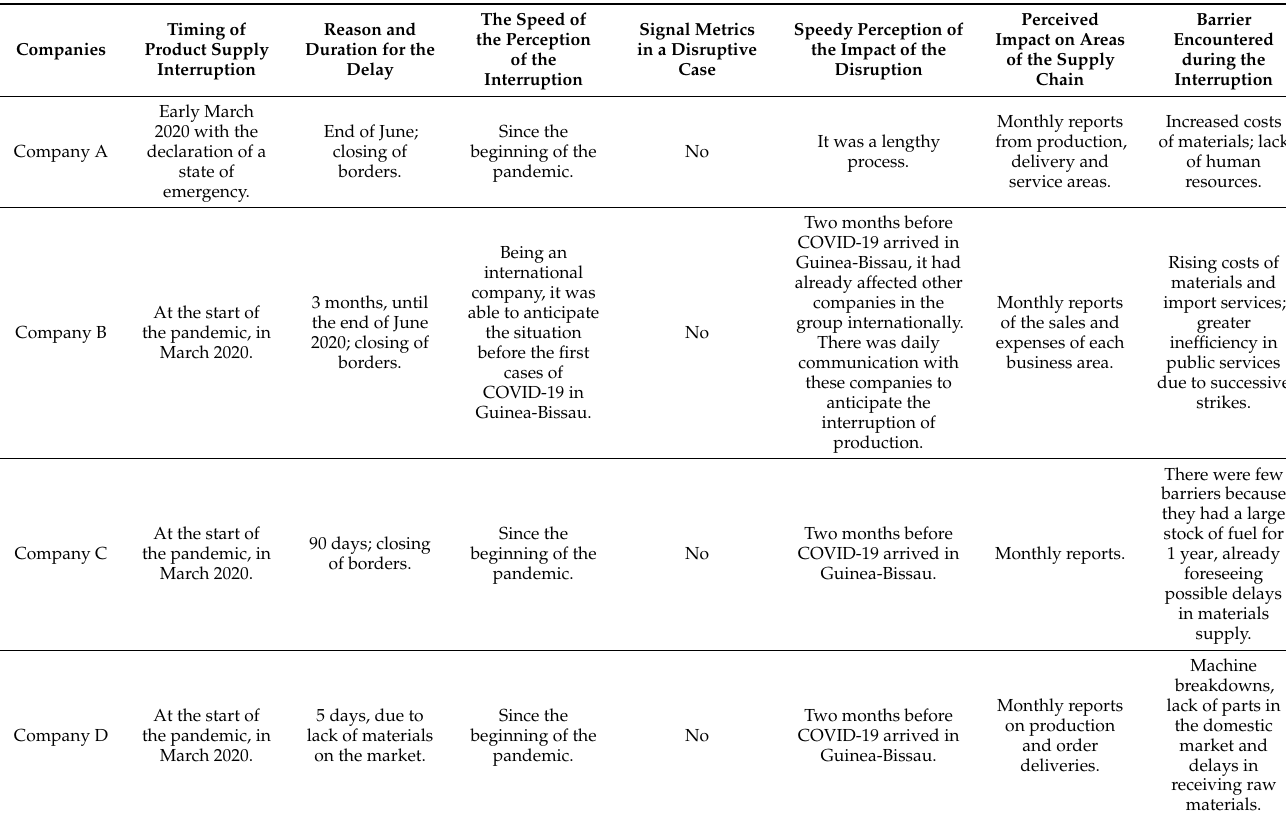
Table 2. Supply Chain Disruptions